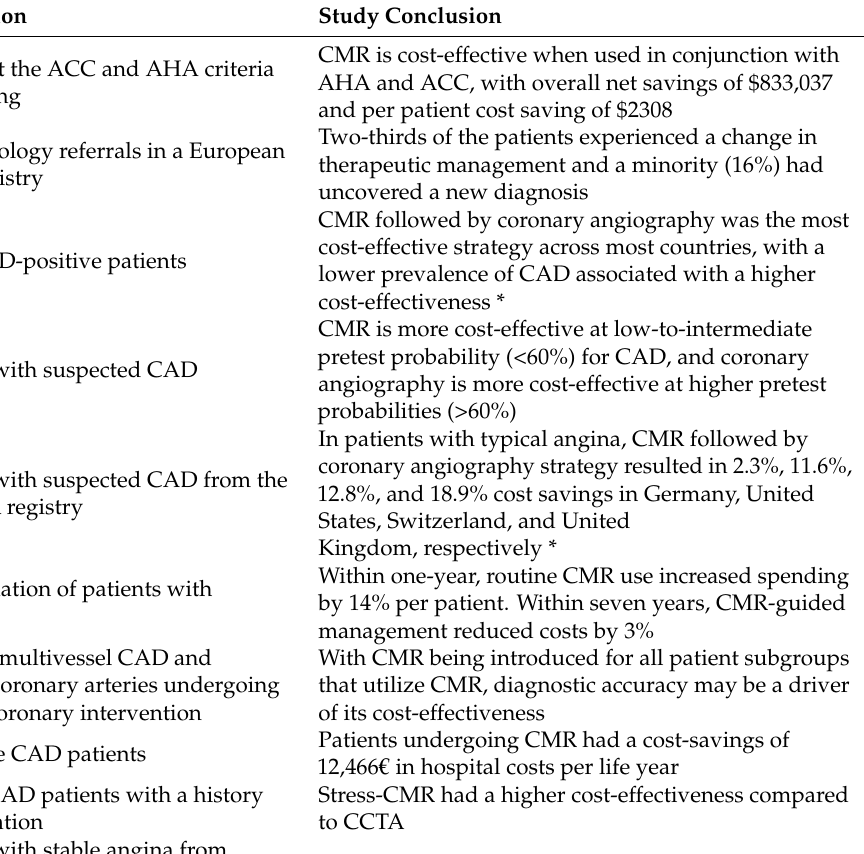
Table 1. Summary of Major Cost-Effectiveness Studies for Cardiovascular Magnetic Resonance